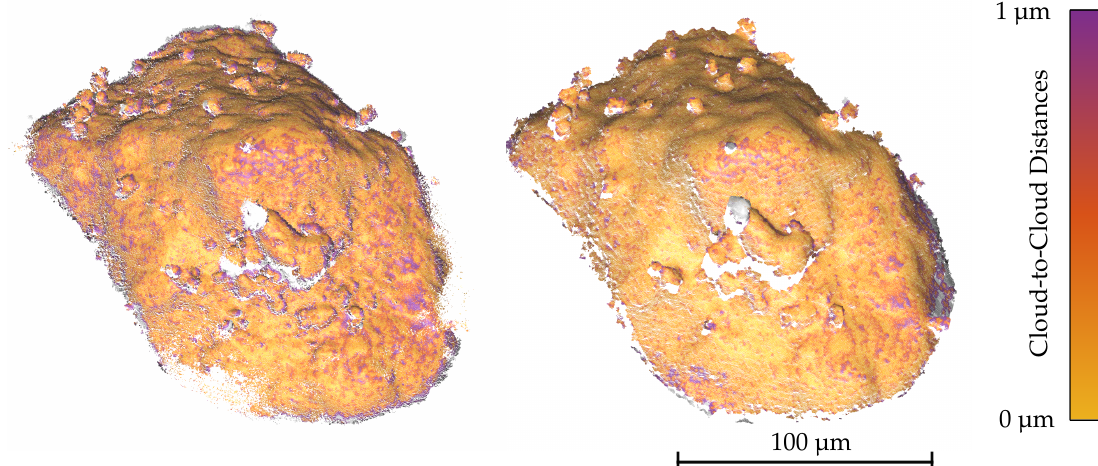
Figure 13. CLSM measurement (left, 969072 points) and the dense point cloud triangulated from a stereo-pair with a tilt angle of ∆ ϕ Y = 10 ◦ (right, 1344742 points) using the weak perspective factorization method. The cloud is coloured in the C2C distances between the two ICP registered point clouds. Unequal missing parts are coloured in white.